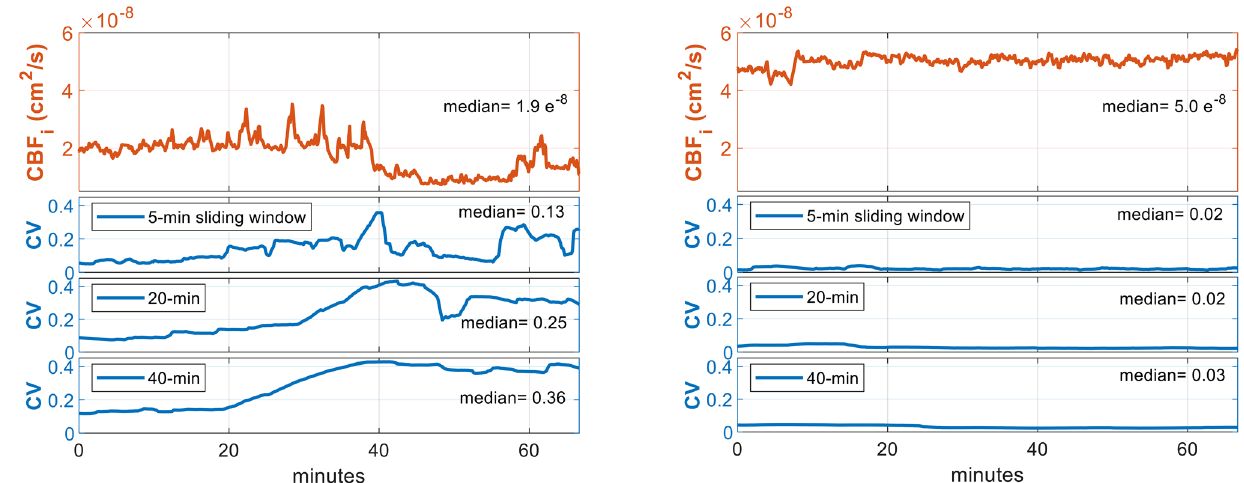
Figure 2. High CBF fluctuation from a 25-week GA ELGA infant with grade IV IVH (Left) was indicated by large (based on the population range shown in Fig. 4b) values of the coefficient of variation (CV) calculated using 5-, 20-, and 40-min sliding windows. Right: In contrast, another ELGA infant with No-IVH (28 weeks GA) showed higher perfusion with low fluctuation, captured by the CV method.